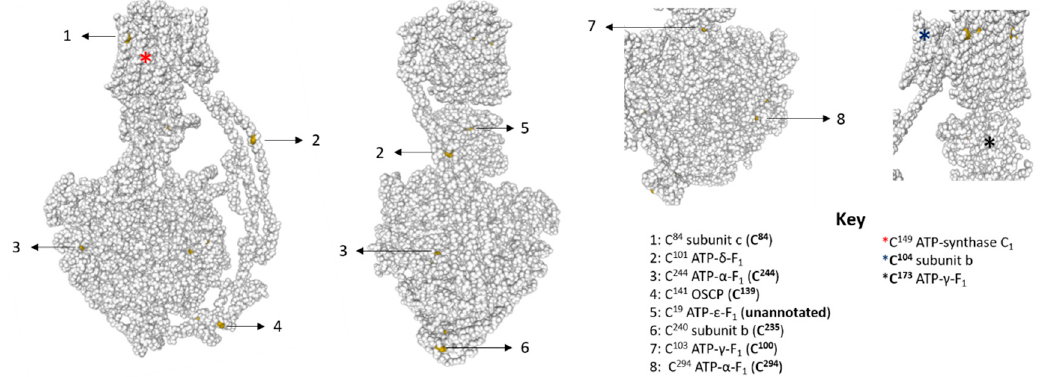
Figure 2. Cysteine residues in bovine F o -F 1 ATP synthase in catalytic state 3A. Numbered cysteine residues are highlighted in yellow. The key lists the cysteine residue by amino acid number for the bovine enzyme with the equivalent X. laevis residue in brackets in bold. A coloured asterix denotes the predicted position of additional cysteine residues in X. laevis. Additional cysteine residues are highlighted in bold in the key if they are likely to be solvent exposed. No structural data is available for subunit g and C3. Table 1. Cysteine residues in F 1 -F o ATP synthase in X. laevis . No annotated information could be found for ATP synthase subunit epsilon (ATP- ε -F 1 ), subunit DAPIT, ATP synthase F(0) complex subunit C2, and ATP synthase subunit e (subunit e).